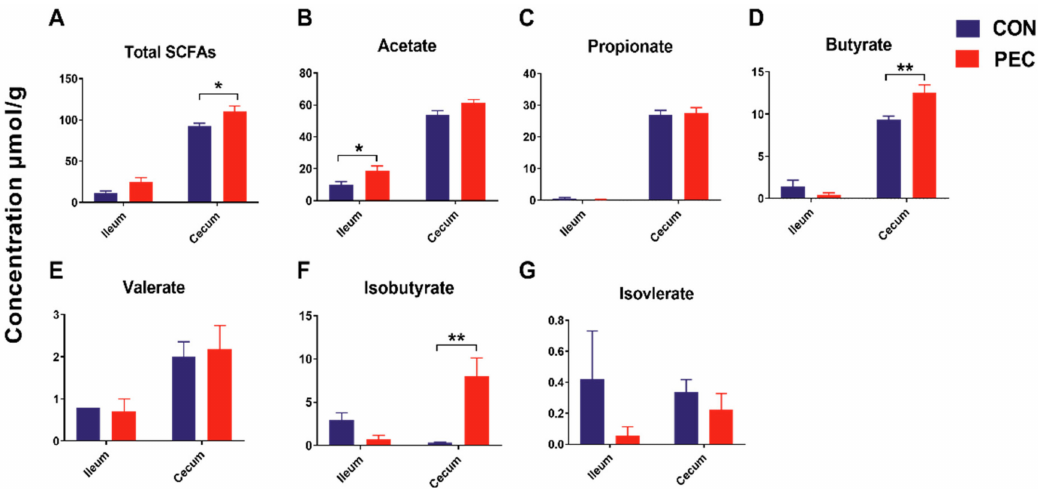
Figure 3. Short-chain fatty acids (SCFAs) concentrations ( µ mol / g) in ileum and cecum of growing pigs fed a diet with or without a 5% pectin supplement. ( A ) Total SCFAs, ( B ) Acetate, ( C ) Propionate, ( D ) Butyrate, ( E ) Valerate, ( F ) Isobutyrate, ( G ) Isovalerate. Total SCFAs are the sum of the following SCFAs: acetate, propionate, isobutyrate, butyrate, isovalerate and valerate. Group di ff erences were tested with a Tukey–Kramer test. ** p < 0.01; * p < 0.05. CON, control; PEC,